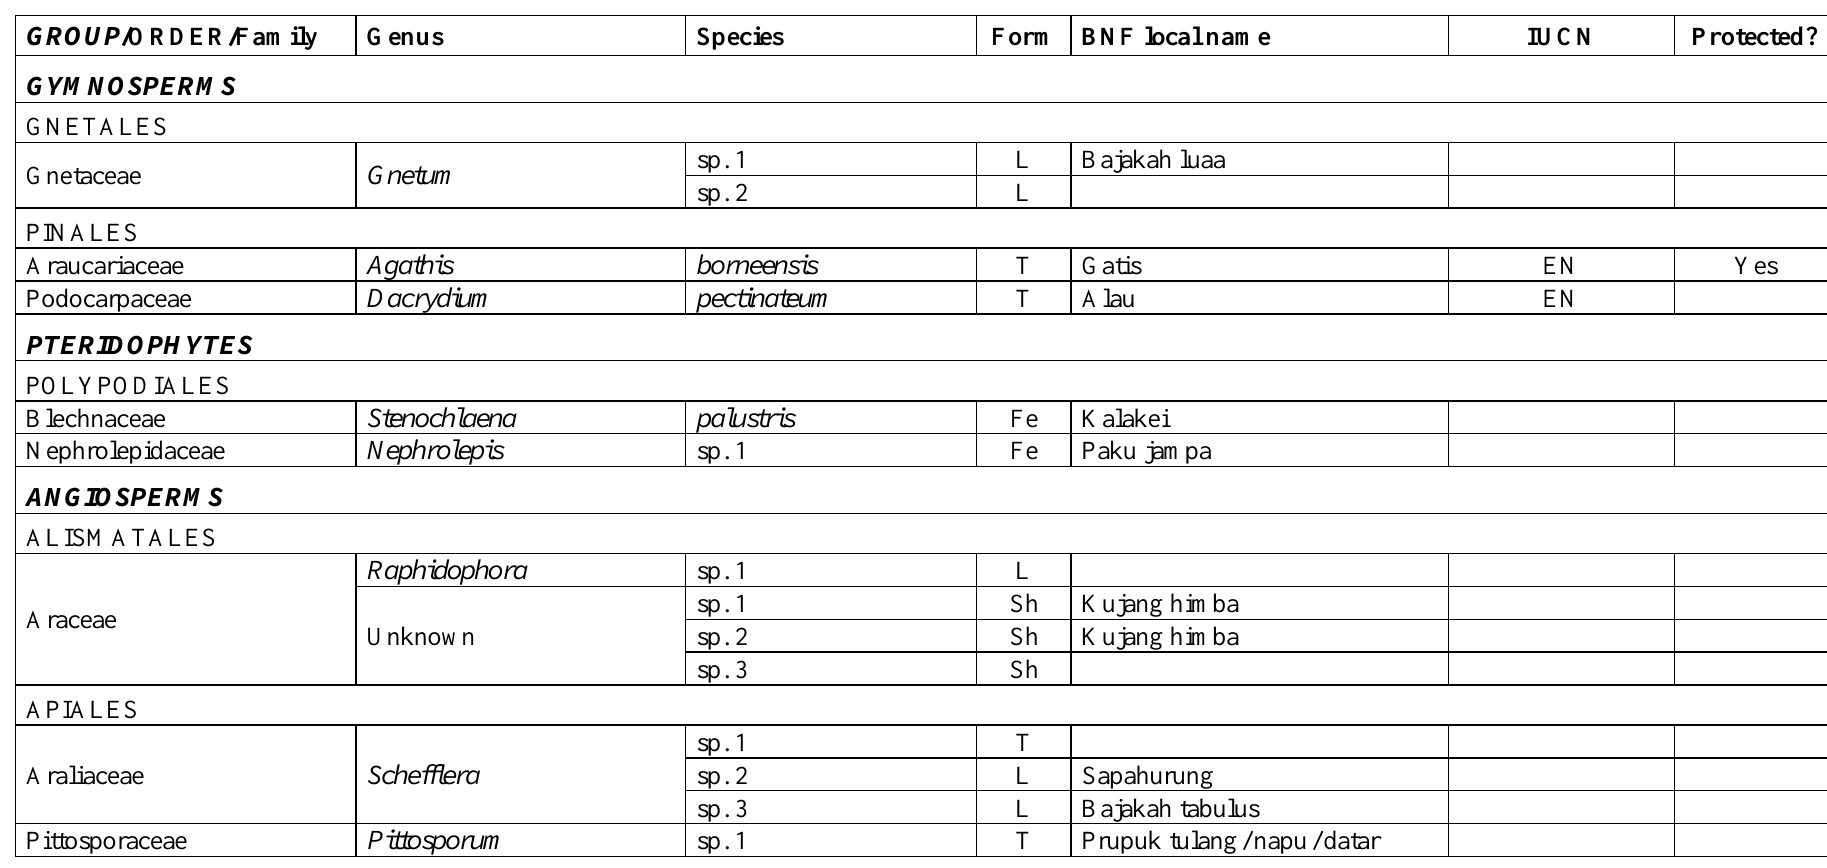
Table A1. List of plant (Plantae) species recorded in the NLPSF, Sebangau. BNF local names indicate those typically used by BNF (Borneo Nature Foundation) botanists and researchers, which commonly match local Dayak names from villages in the Sebangau area. IUCN Red List classifications are provided (CR = critically endangered; DD = data deficient; EN = endangered; LC = least concern; NT = near threatened; VU = vulnerable), and ‘Protected?’ refers to protection status in Indonesia. Parentheses for Latin names indicate synonyms, with those recommended by the Taxonomic Name Resolution Service prioritised; for local names, optional/ occasionally used parts of the name or spelling variations. Slashes for Latin names indicate cases in which identification between two classifications is uncertain; for local names they indicate alternatives. Forms: C = climber; E = epiphyte; Fe = fern; Fi = fig; L = liana; O = orchid; P = parasitic; Se = sedge; Sh = shrub; T =